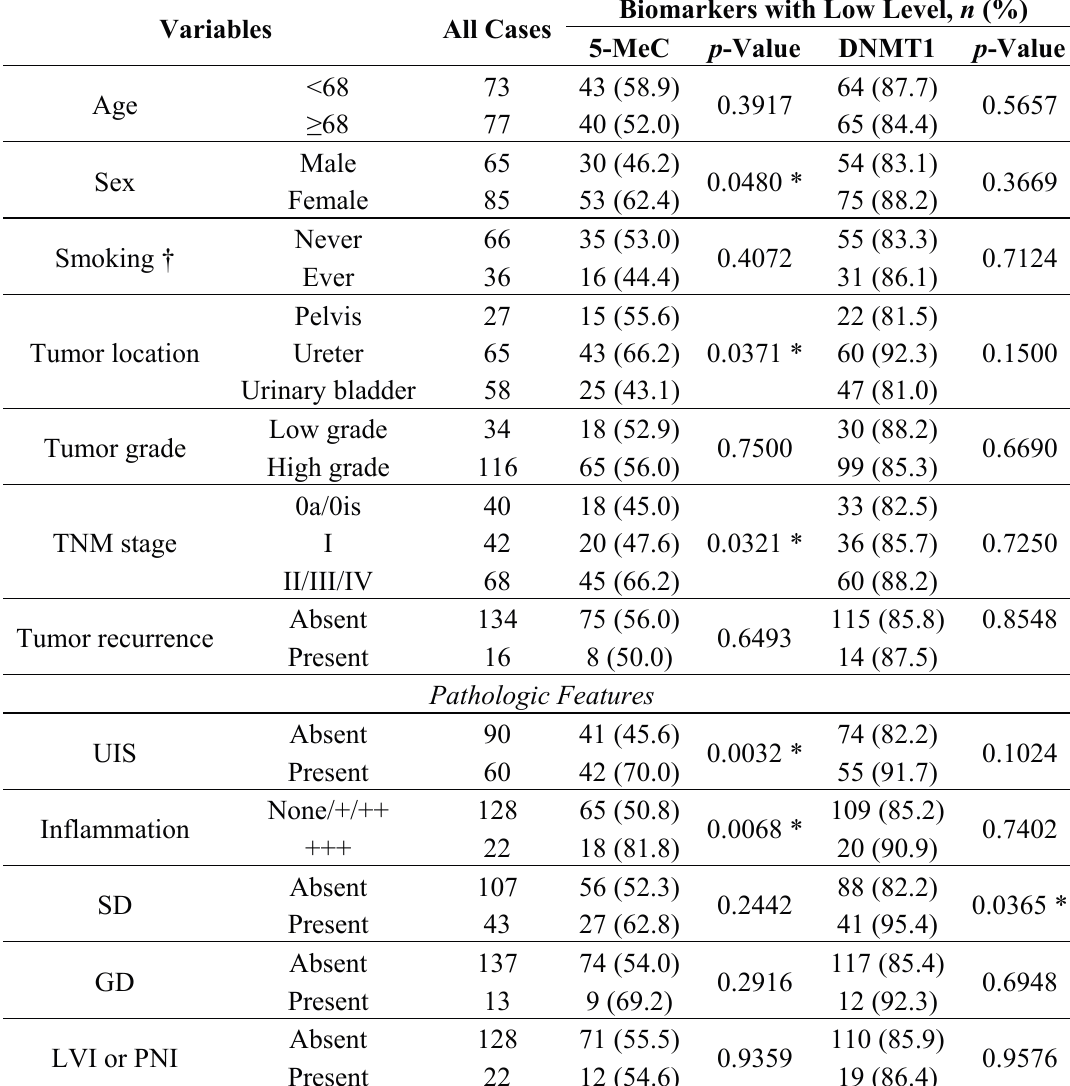
Table 3. Comparison of UCs with low 5-MeC or DNMT1 level stratified by clinicopathological features ( n = 150).